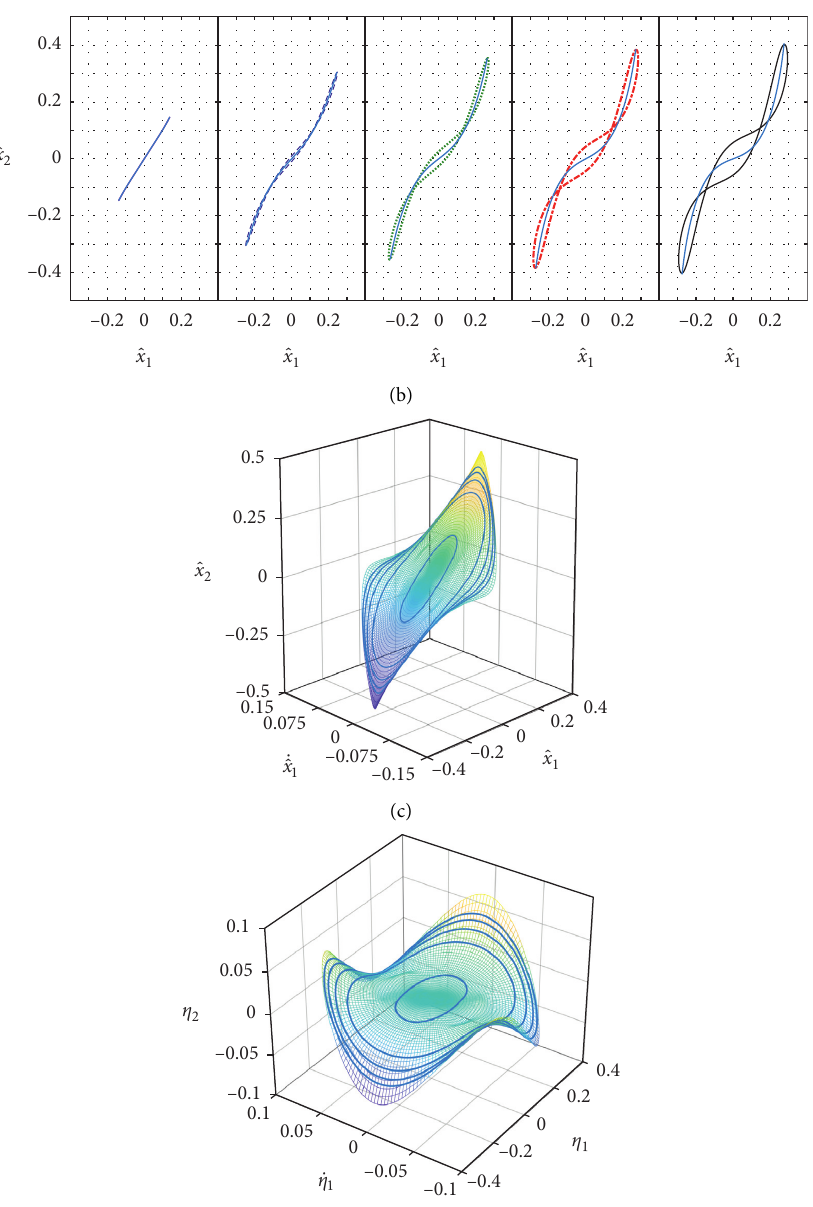
Figure 10: The forced responses of a type III two-stage isolator in primary resonance, for 􏽢 k motions on the approximate NNM invariant manifold for the underlying conservative system. (a) Displacement amplitude-frequency responses for the payload and the ones for the lower stage of the isolator under force excitations with increasing frequency and different amplitude F : pink solid line represents F � 0 . 0001; blue dashed line represents F � 0 . 0005; green dotted line represents F � 0 . 0010; red dashed-dotted line represents F � 0 . 0015; black solid line represents F � 0 . 0020; the other system parameters are the same as in Figure 2. (b) Five representative forced responses in primary resonance of the system shown in different line styles, which correspond, respectively, to the solid points on the curves in (a) with the same color and line style. Five corresponding free periodic trajectories of the underlying conservative system are shown in solid lines. (c-d) The approximation of the NNM invariant manifold for the displacement constraint 􏽢 x ( 􏽢 x , _ 􏽢 x ) and η ( η , _ η ) , respectively. The parameters set in the numerical solution procedure are N 2 1 1 2 1 1 � 10. The five free periodic motions from (b) are also shown as solid curves in each phase in the domain a | a ∈ [ 0 , 0 . 35 ]{ } , and N ϕ